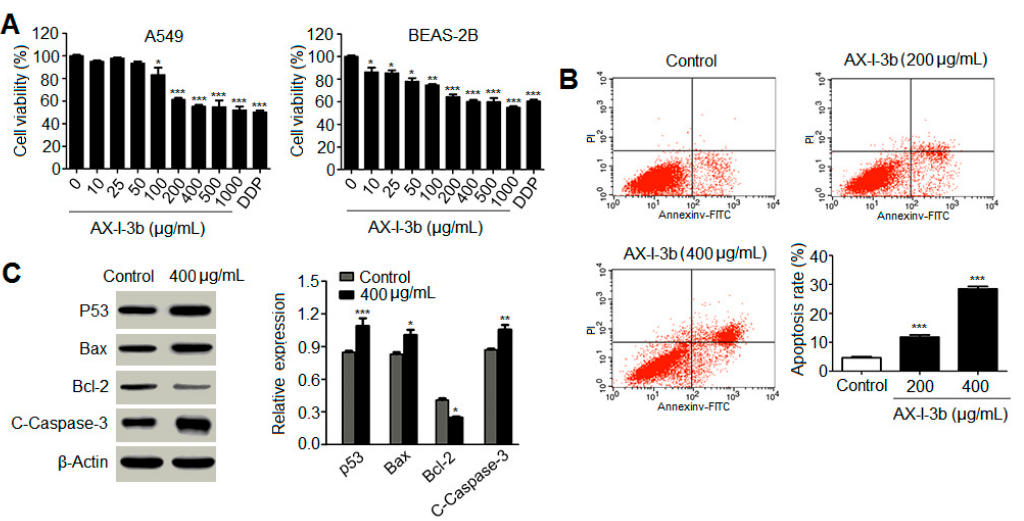
Figure 10. Effect of AX-I-3b on A549 cells. ( A ) Effect of AX-I-3b on the cell viability of A549 cells; ( B ) The apoptosis detection of A549 cells induced by AX-I-3b; ( C ) Effect of AX-I-3b on apoptosis protein and anti-apoptotic protein expression in A549 cells by Western blot analysis. Values are means ± SD (n = 3). * p < 0.05, ** p < 0.01 and *** p < 0.001 as compared with the control.